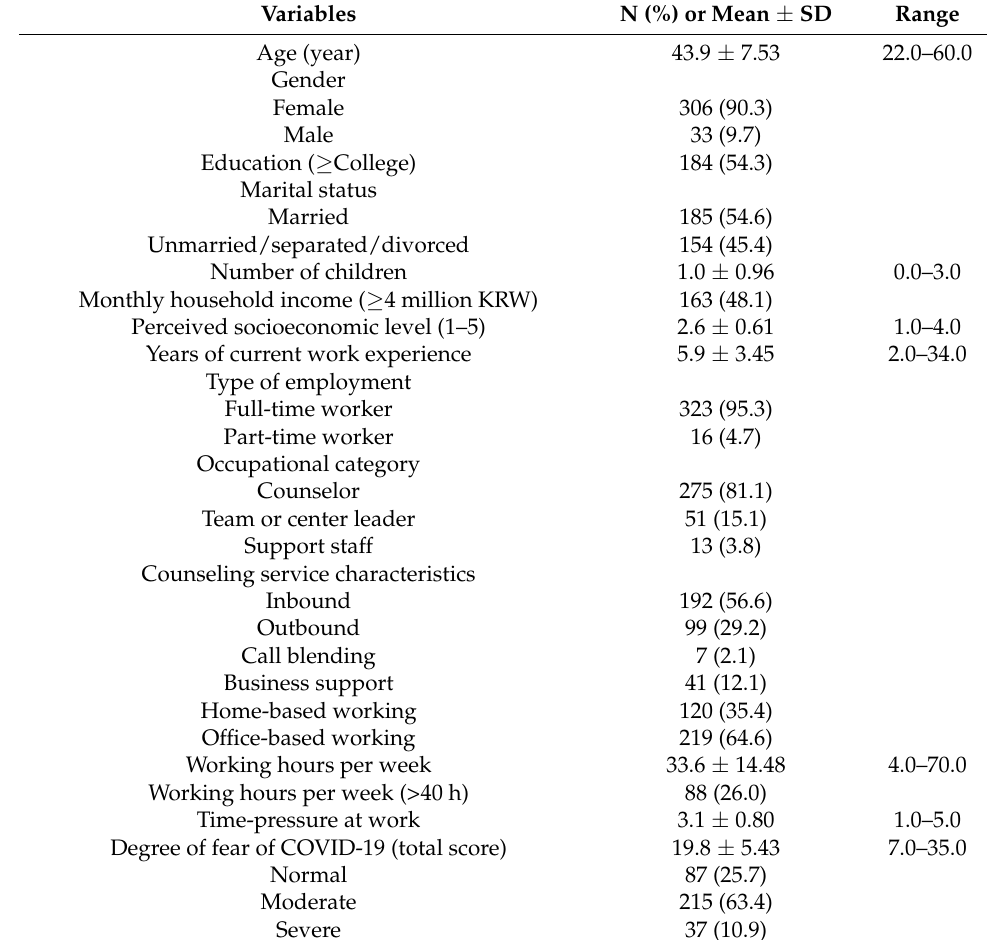
Table 1. General Characteristics of Participants (N =